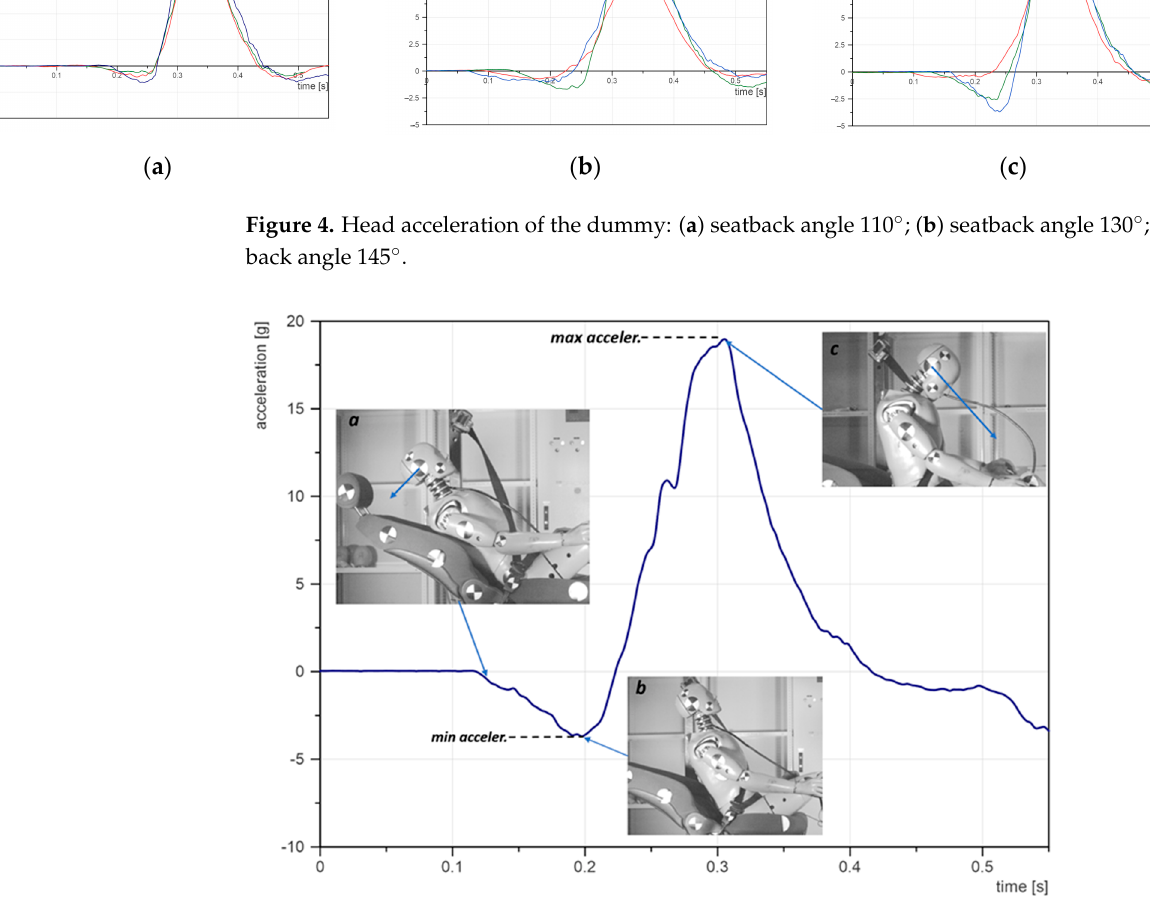
Figure 5. Explanation of the hat acceleration signal: ( a ) backwards motion of the head provoking a negative acceleration; ( b ) change of heads direction of motion; ( c ) forward motion of head provoking the pick of acceleration.